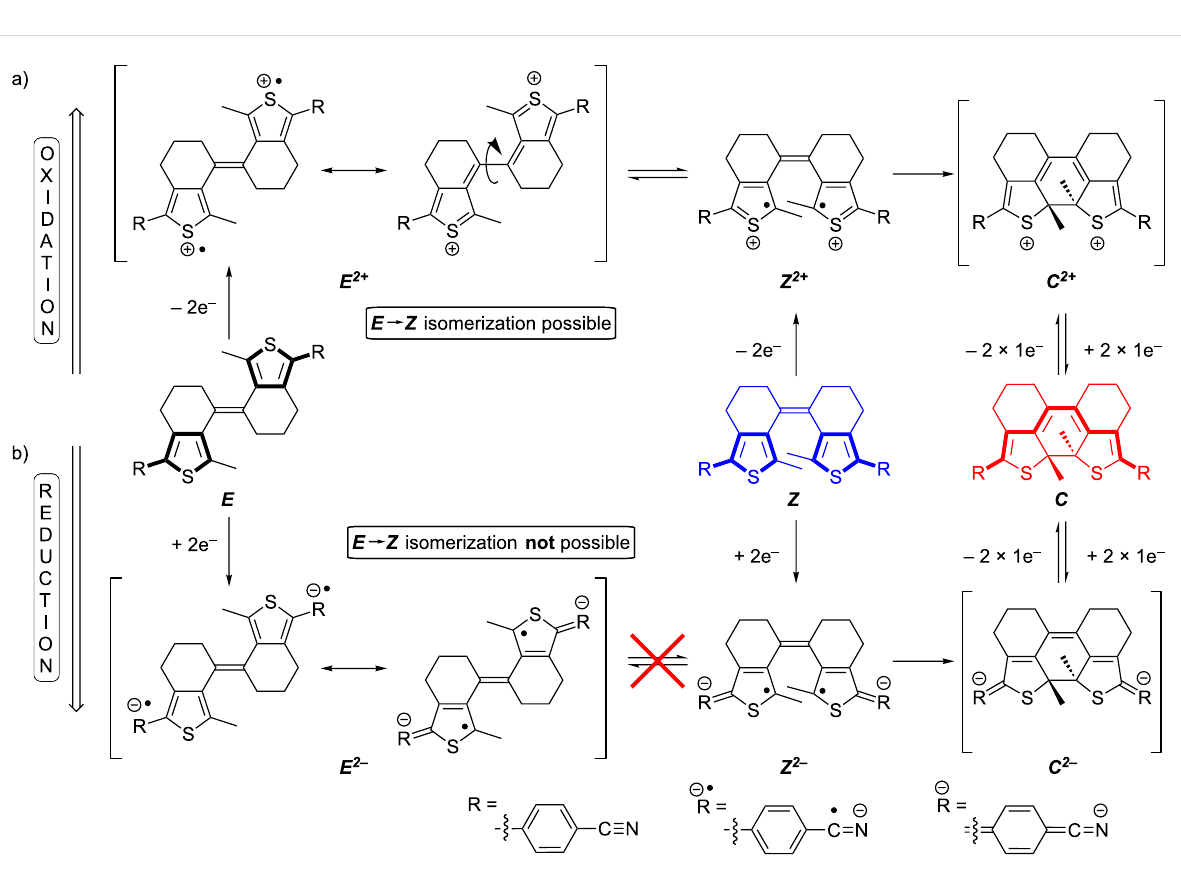
Scheme 4: Proposed mechanism to explain the observed selectivity of anodic and cathodic cyclization in sDTE 66 derivatives: a) Upon two-fold oxida- tion, an equilibration between the two dications of the E- and Z- isomers is possible due to rotation about the formed central single bond. Once formed, Z 2+ is trapped as C 2+ . b) In contrast, bond rotation is not possible for the dianion E 2 − and as a consequence, reductive cyclization is only possible from Z 2 −